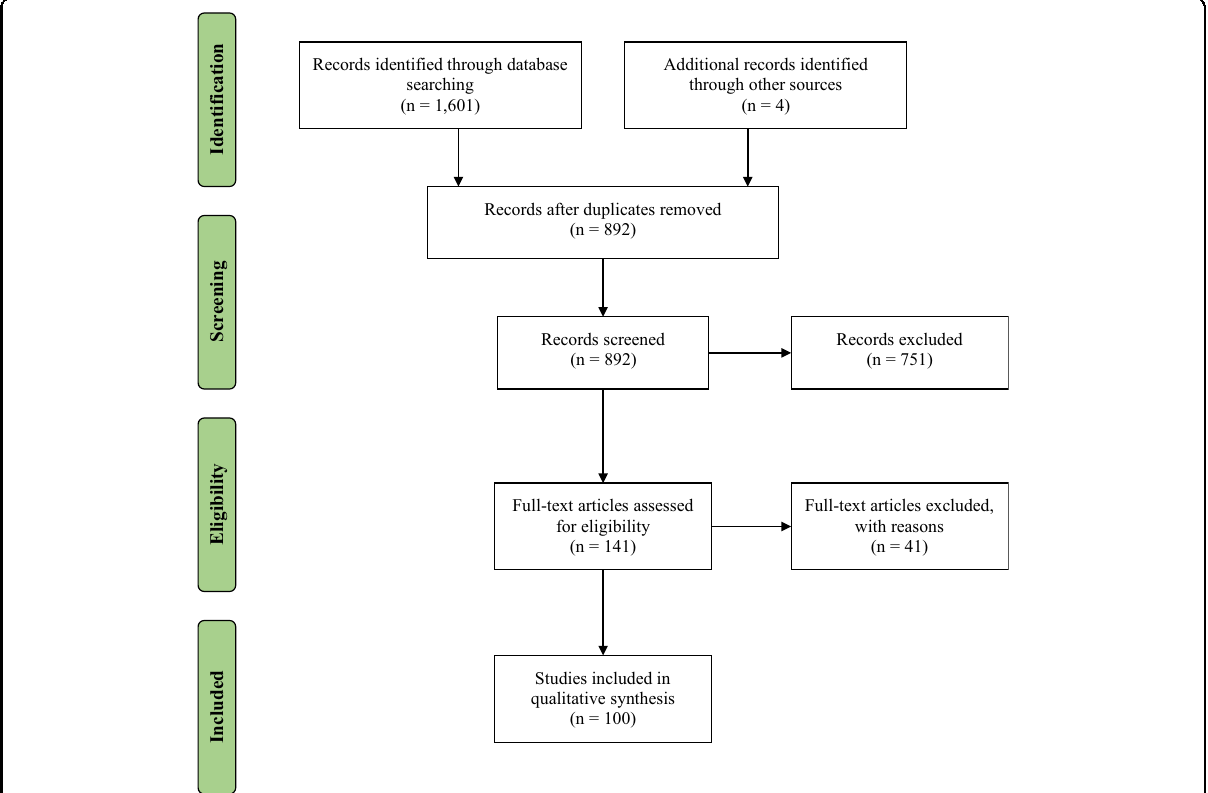
Fig. 1 PRISMA fl ow diagram. Note: Records screened refers to both titles and